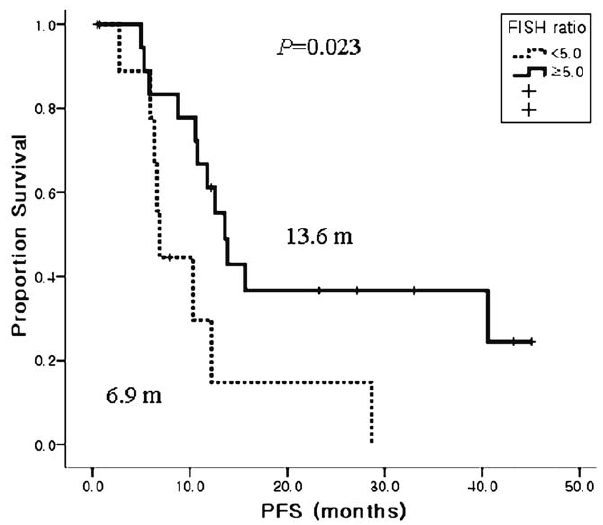
Figure 4. Kaplan-Meier estimates of PFS according to HER2 FISH amplification index (AI). The patients with high HER2 FISH AI tumors had significant.